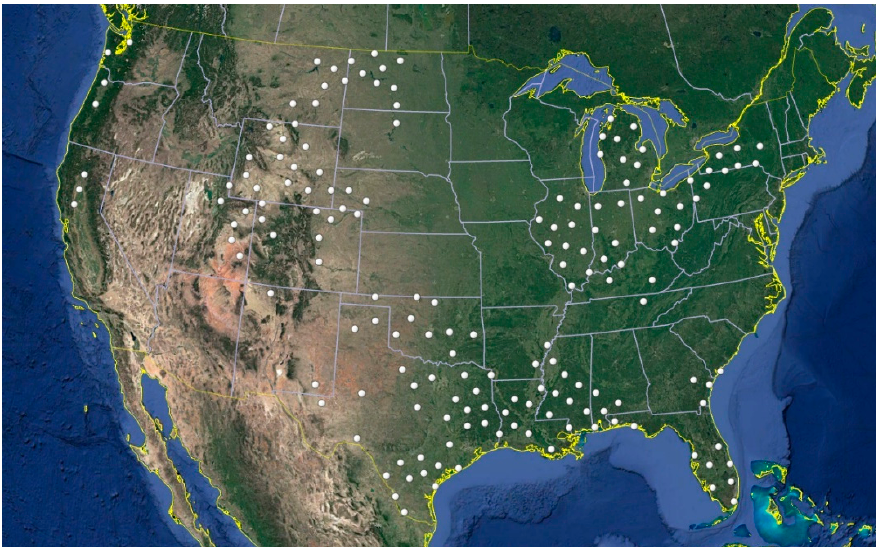
Figure 4. Candidate county-level BECCS facility locations used in this analysis based on selection Figure4. criteria.